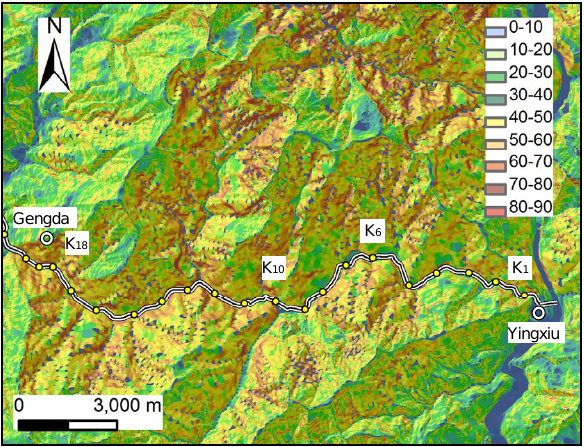
Fig. 3. Gradient of the natural terrain in the study area.